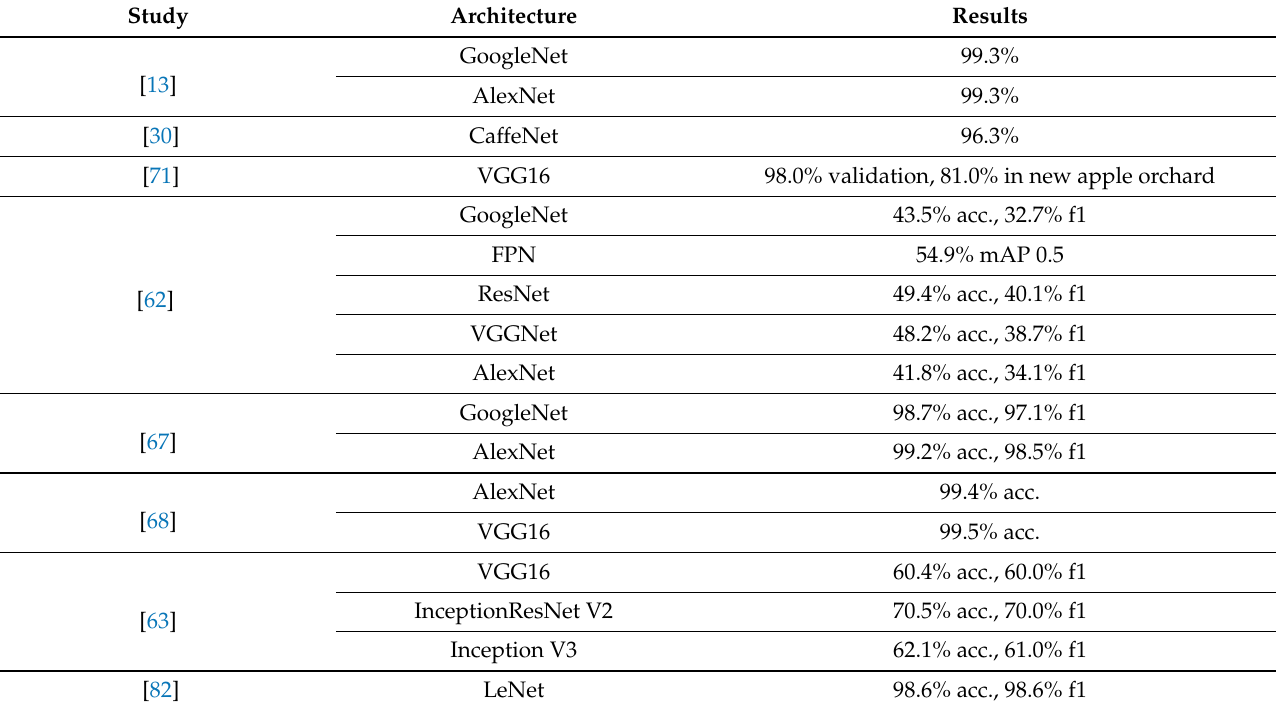
Table 5. Performance of CNN